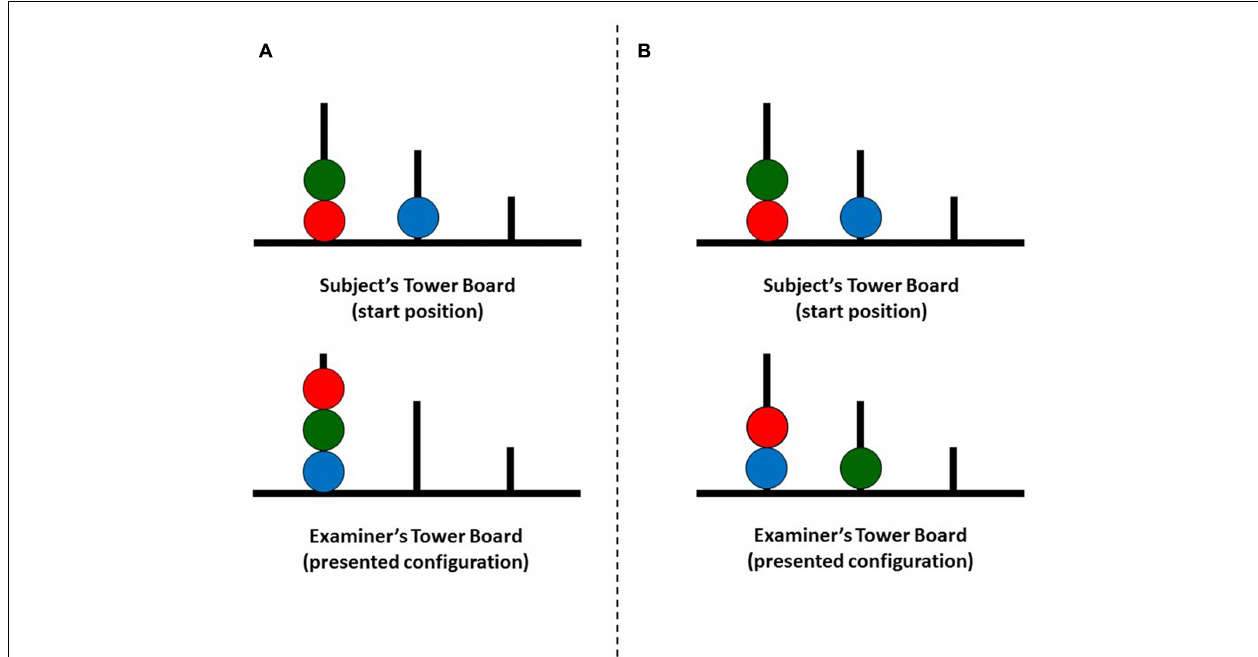
TABLE 2 | The TOL DX outcome measures grouped into three main categories reflecting cognitive processes underlying the test performance. Category Particular outcome measures Definition